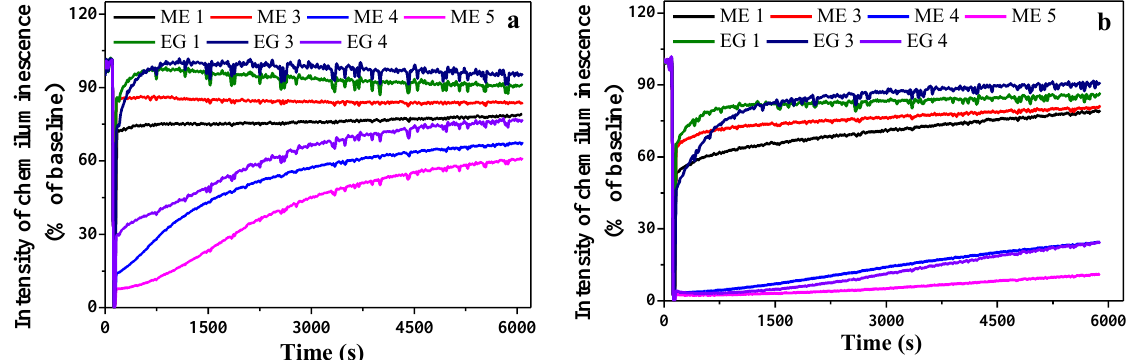
Figure 5. Graph of the change in the level of chemiluminescence in time with the addition of 5 µL ( a ) and 10 µL ( b ) of the tested microemulsions or emulgels in 1 mL of luminol solution.